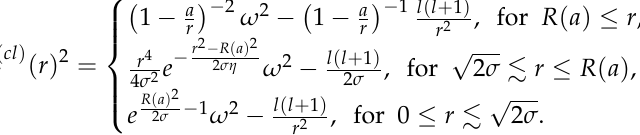
Figure 11. The classical effective potential p ( cl ) ( r ) 2 > 0 is allowed The region of p i